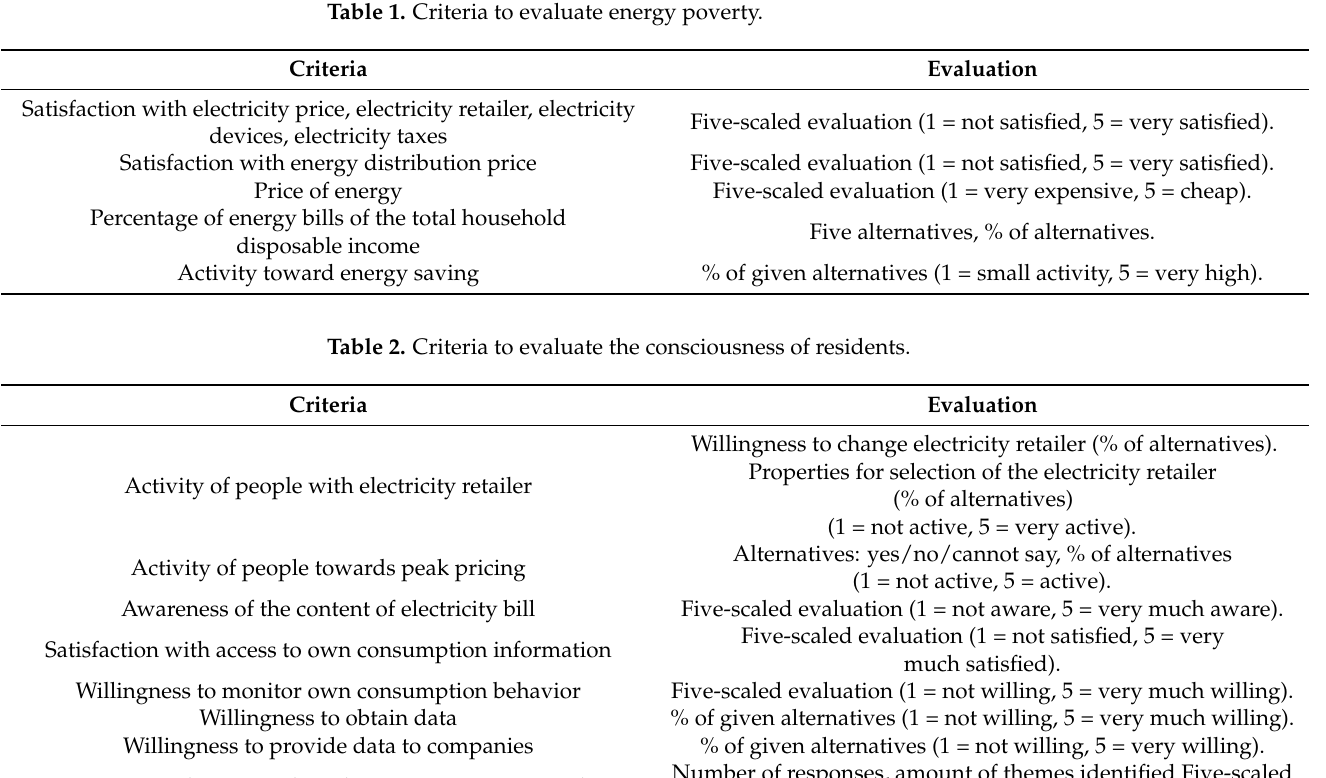
Table 1. Criteria to evaluate energy poverty.